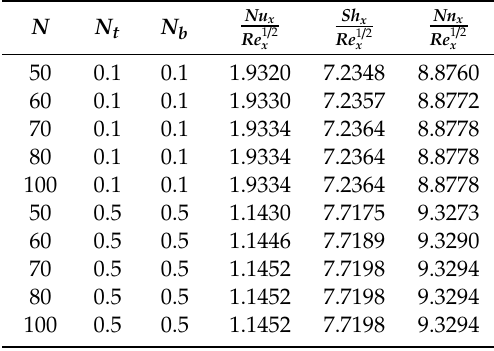
Table 1. Numerical convergent values of Nusselt number, Sherwood Number, and the local density number of the motile microorganisms across N , N t , and N b by fixing M = 1, β D = E c = 0, N r = 0.5, R b =